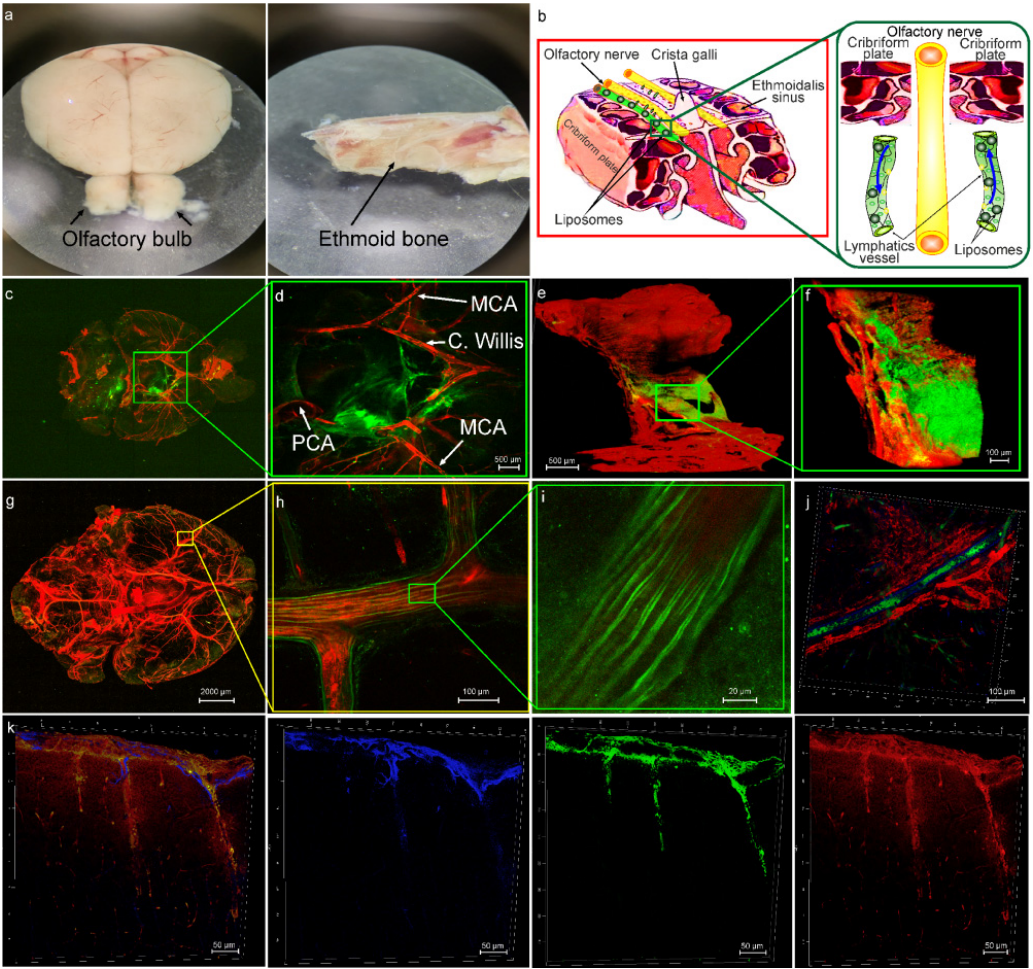
Figure 1. The lymphatic pathway of delivery of liposomes (green) to mouse brain from the HG group: ( a ) Images of the ethmoid bone and the olfactory bulb, which were used for confocal and multiphoton imaging of distribution of liposomes after its intranasal injection; ( b ) schematic illustration of hypothesis that after intranasal administration, liposomes with the extracellular fluids enter the lumen of LVs in the nasal mucosa and are drained in both directions, from and into the brain via the space between the OSN providing directed fluid flow; ( c ) representative confocal image of ventral part of the brain after intranasal injection of liposomes (green), the cerebral vessels were filled with the Evans Blue dye (red, i.v.); ( d ) representative confocal image of region of interest from ( c ), the image shows distribution of liposomes (green) along the main arterial vessels: MCA: middle cerebral artery, C. Willis: Circle of Willis, PCA: posterior cerebral artery; ( e )—multiphoton image of the cribriform plate immersed in buffer solution and covered with cover glass. Objective—10 × 0.45, two photon fluorescence excitation 970 nm, emission: green (liposomes) 506—593 nm; red (Evans Blue) 604—679 nm; ( f ) multiphoton image of region of interest from ( e ), the image demonstrates distribution of liposomes (green) in the freshly removed cribriform plate stained with Evans Blue (red, emission 604—679 nm); ( g ) whole imaging of the mouse brain after intranasal delivery of liposomes; ( h , i ) the region of the middle cerebral artery (red, filled with Evans Blue) depicting directional distribution of liposomes; ( j ) the presence of liposomes (green) in the MLVs labeled with Live-1 (blue), the blood vessels (red) filled with Evans Blue; ( k ) representative images of distribution of liposomes (green) along the brain surface, astrocytes are labeled with GFAP (blue), the cerebral blood vessels were filled with Evans Blue (red).